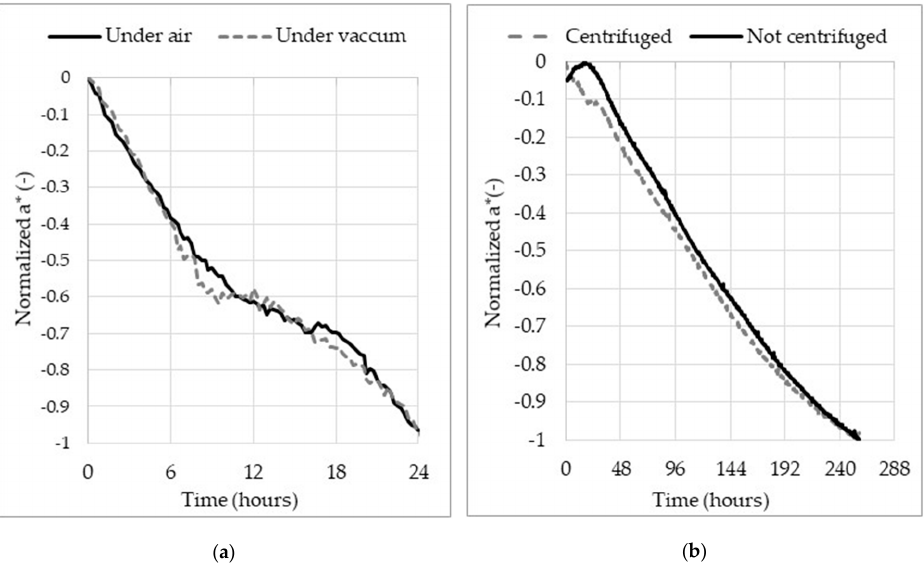
Figure 3. Monitoring of the color change (normalized values of a*) as a function of time for ( a ) a rib steak juice (50 mL of centrifuged juice, filtered and 1/5 diluted) at 20 °C depending on the type of packaging (air, in black solid line), or under vacuum, in grey dashed line) and ( b ) a rib steak juice (50 mL of filtered juice and diluted 1/5) at 4 °C with, in grey dashed line, or without, black solid line, the step of centrifugation (centrifuged or not centrifuged).